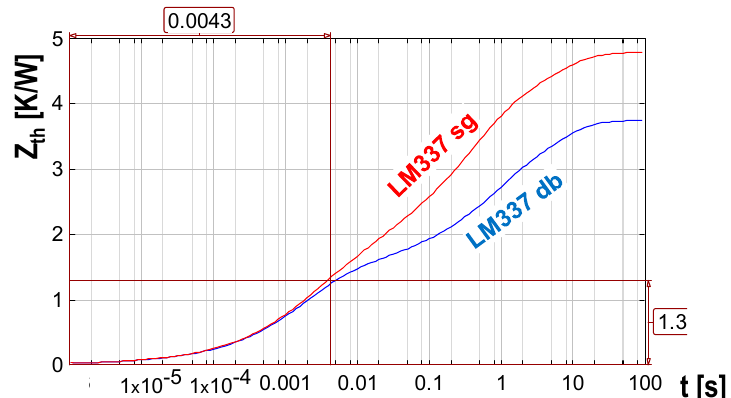
Figure 17. Z th curves of stabilizer IC in TO-220 package: single gauge and double gauge.